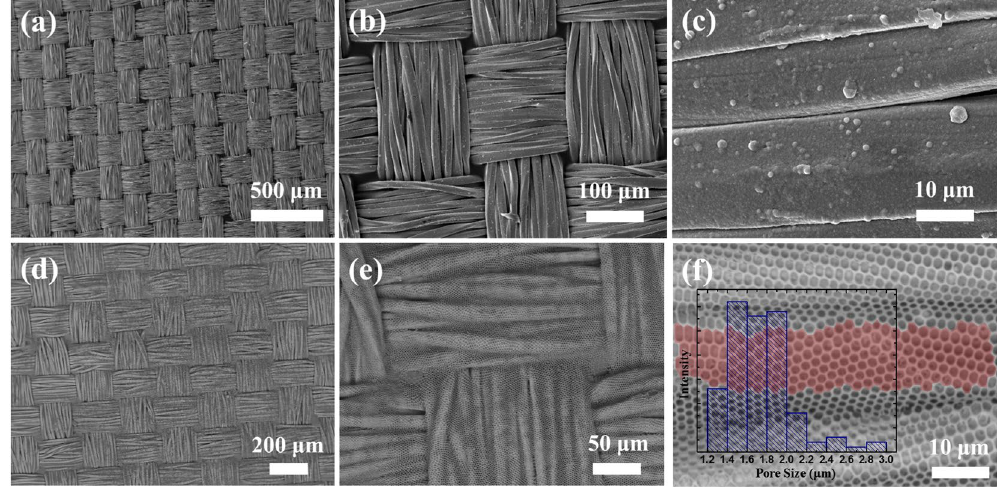
Figure 1. SEM images of CNF fabric ( a–c ) before and ( d–f ) after the conformal formation of 3D honeycomb porous microstructures via BFs. The concentration of casting solution was 15.0 mg mL − 1 . The inset is the pore size distribution of highlighted